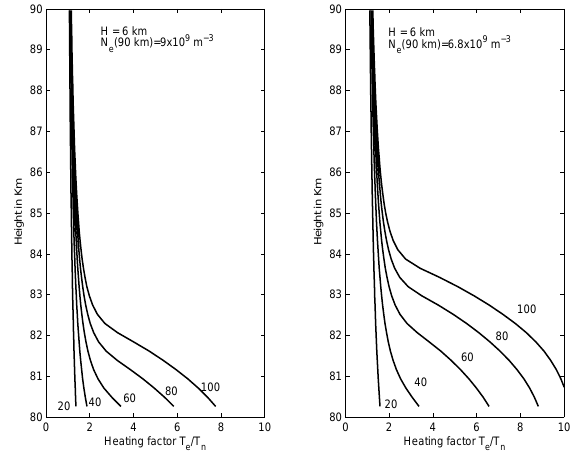
Fig. 6. The change of heating, for two electron density profiles, as the heater transmitter power is changed from full power (100) in steps of 20% down to 20% of full power (20). The left-hand cases, with the highest electron density profile, are taken to represent the case 08:00–09:00 UT in Fig. 5, where the average heating factor between 81–89km is shown as a broken line. The lowest electron density profile on the right is taken to represent the case for 10:00– 11:00 UT in Fig. 5. ERP=700MW.